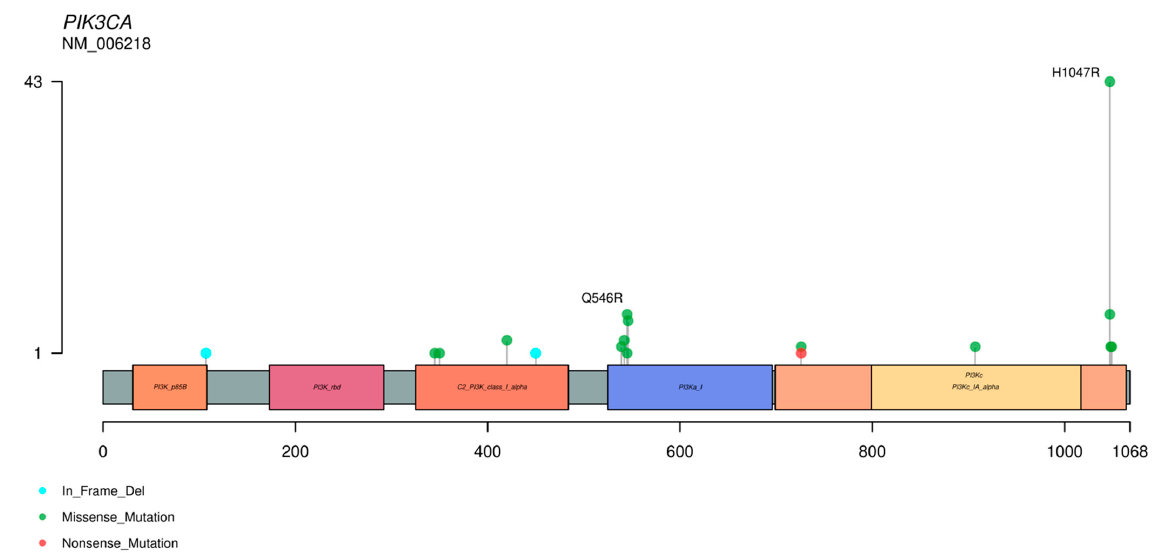
Figure 5. Representation of the distribution of mutations in the PIK3CA gene. These data were obtained from the review of reference [11].